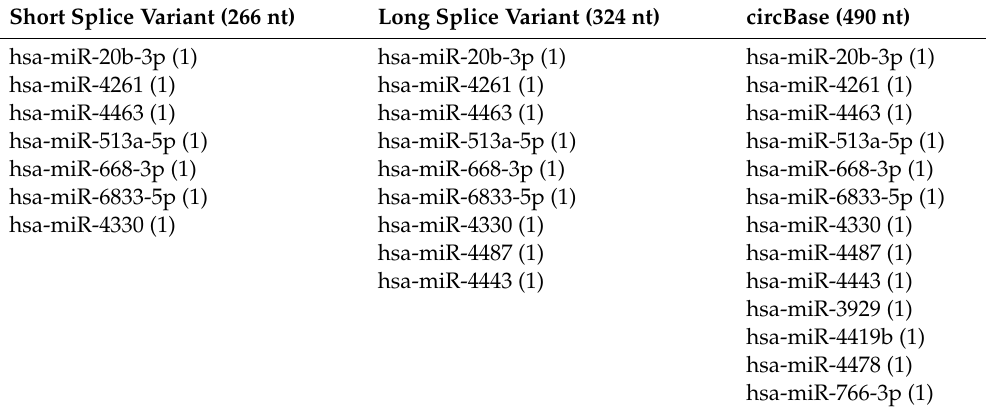
Table 2. List of miRNAs predicted to associate with circBase and splice variant sequences of hsa_circ_0007127 using the miRDB web tool. The number of binding sites for each miRNA is indicated in